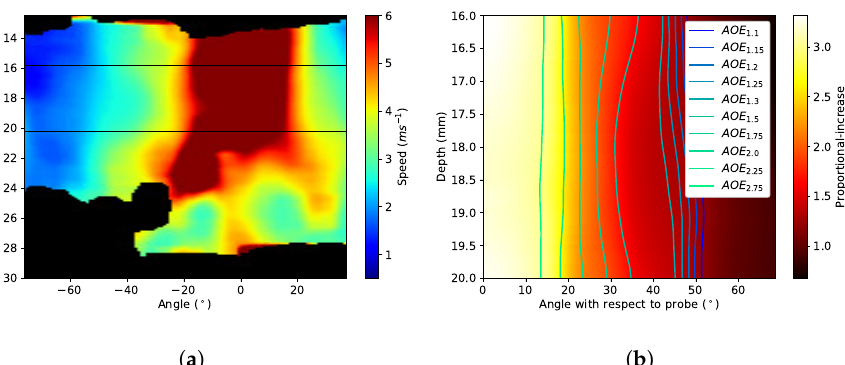
Figure 9. ( a ) Sample elastogram of a patient in polar coordinates with the marked area of interest. ( b ) Sample elastogram with angle measured from the central axis of applied force. Contours on the image mark borders of proportional increase for thresholds from 1.10 to 3.00. Areas within the borders have proportional increase from base speed higher than stated